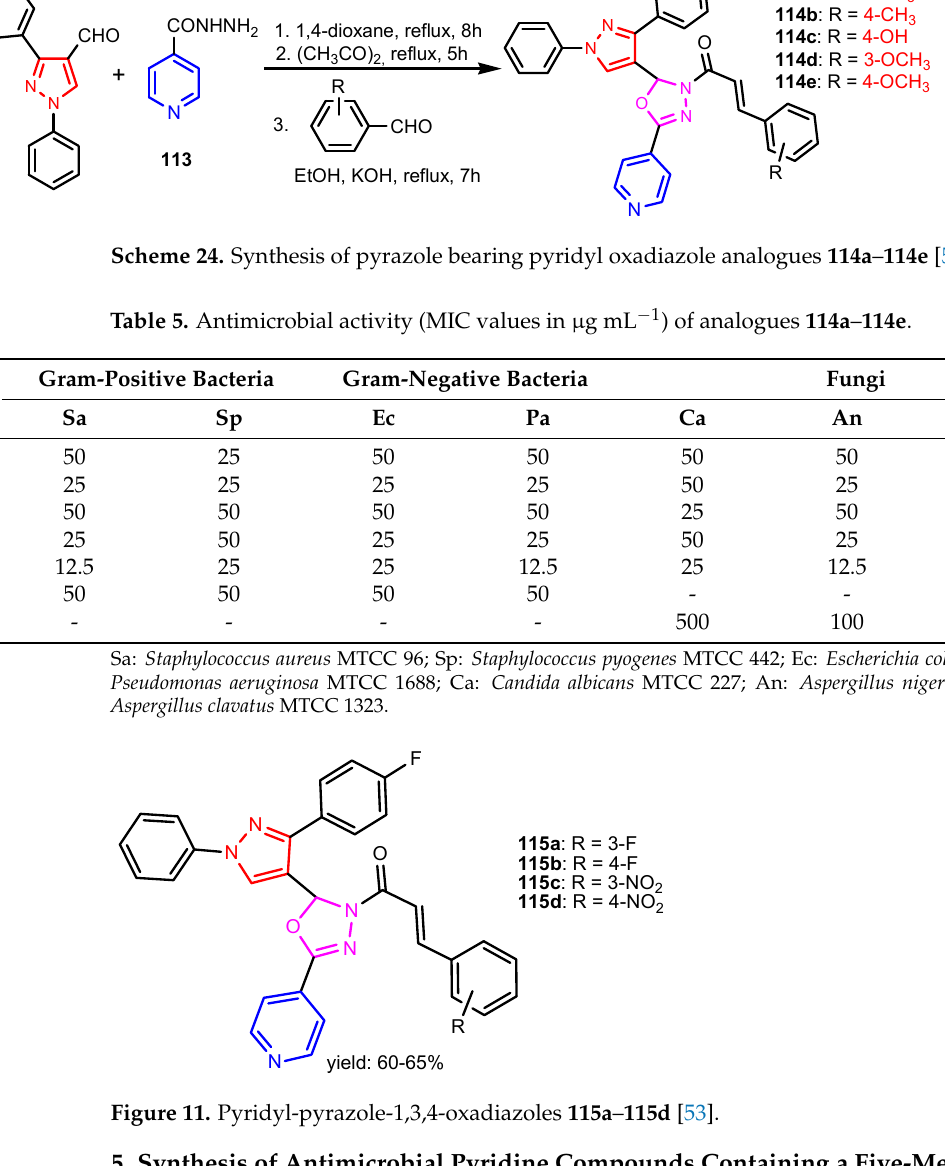
luteus, K . pnemoniae MIC 37.5 µ g mL − 1 , and compounds 117a and 117b exerted antifungal activity better than standard drug, Cycloheximide.